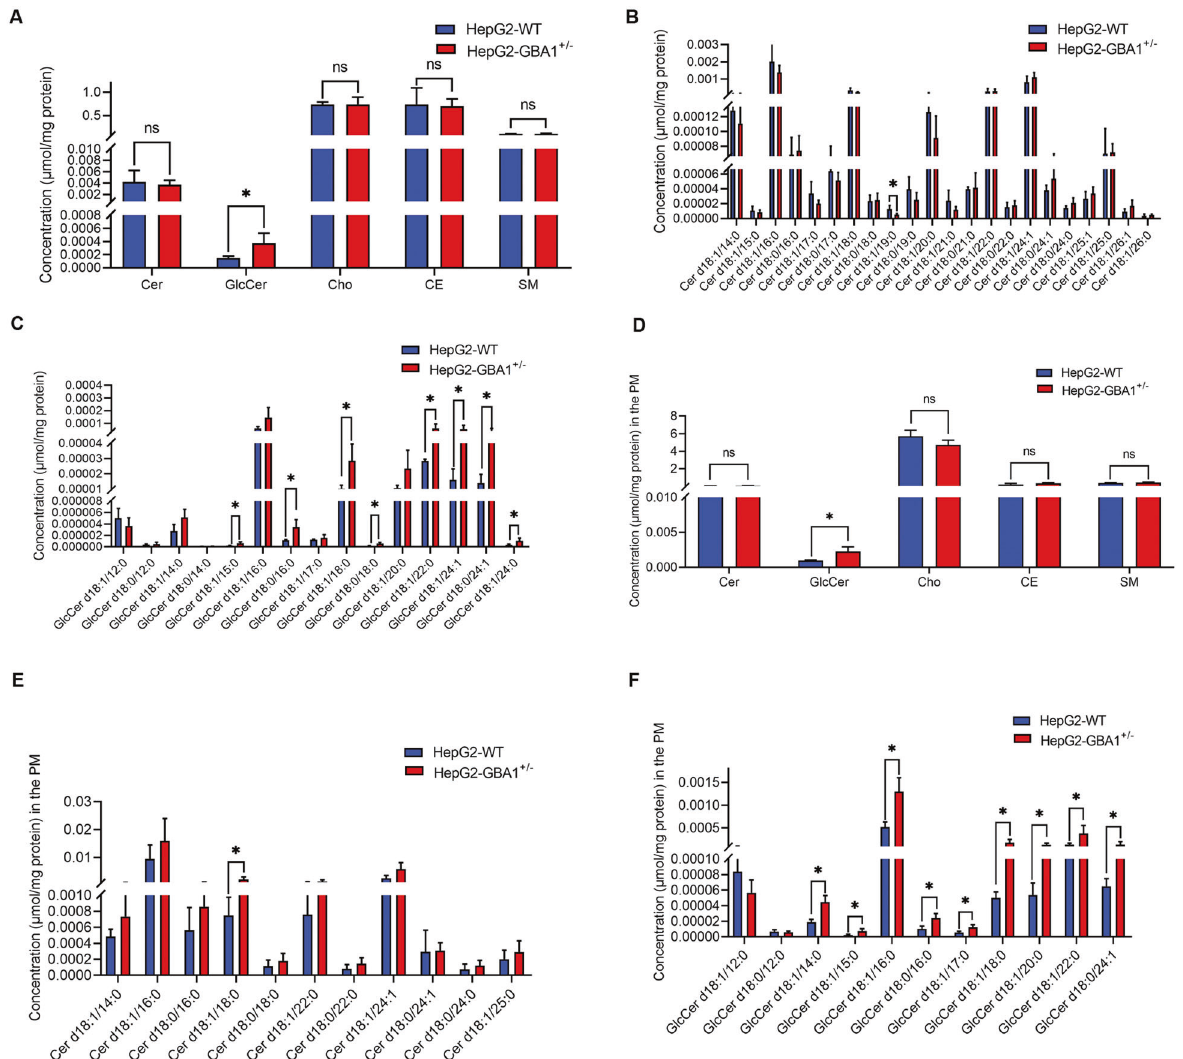
Fig. 4 GBA1 regulates the GlcCer levels in whole liver cancer cells and the plasma membrane of liver cancer cells. A Total levels of GlcCer, Cer, cholesterol, cholesteryl esters, and sphingomyelin in HepG2 cells with stable GBA1 downregulation ( n = 4/WT group, n = 4/ downregulated group) were measured by mass spectrometry. Data are shown as concentrations ( μ mol/mg protein), and signi fi cance was determined by Student ’ s t test. B , C Levels of subspecies of Cer and GlcCer in HepG2 cells with stable GBA1 downregulation ( n = 4/WT group, n = 4/downregulated group) were analysed by mass spectrometry. The data are shown as concentrations ( μ mol/mg protein), and signi fi cance was determined by Student ’ s t test. D Total levels of GlcCer, Cer, cholesterol, cholesteryl esters, and sphingomyelin in the plasma membrane of HepG2 cells with stable GBA1 downregulation ( n = 4/WT group, n = 4/downregulated group) were measured by mass spectrometry. The data are shown as concentrations ( μ mol/mg protein), and signi fi cance was determined by Student ’ s t test. E , F Levels of subspecies of Cer and GlcCer in the plasma membrane of HepG2 cells with stable GBA1 downregulation ( n = 4/WT group, n = 4/downregulated group) were analysed by mass spectrometry. The data are shown as concentrations ( μ mol/mg protein), and signi fi cance was determined by Student ’ s t test. * p < 0.05; ns, not signi fi